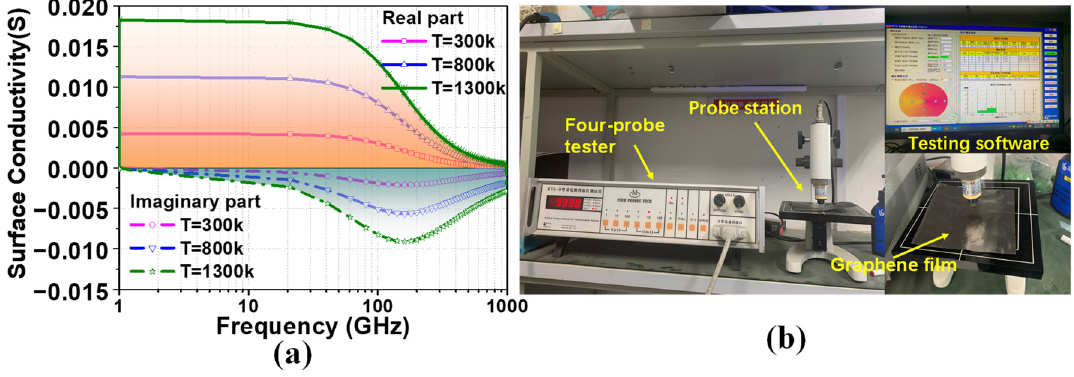
Figure 2. ( a ) Calculation and ( b ) measurement of the surface conductivity of the CGF.